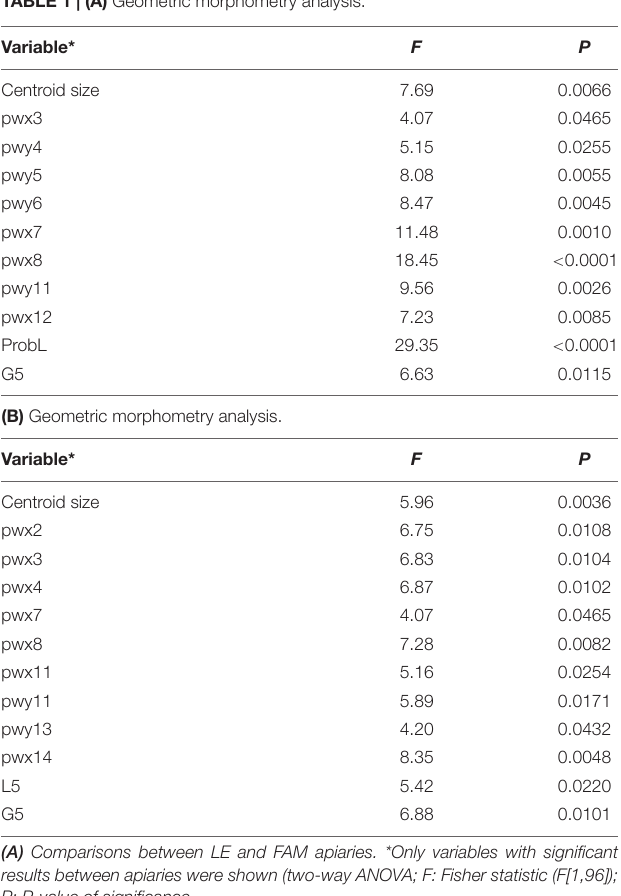
TABLE 1 | (A) Geometric morphometry